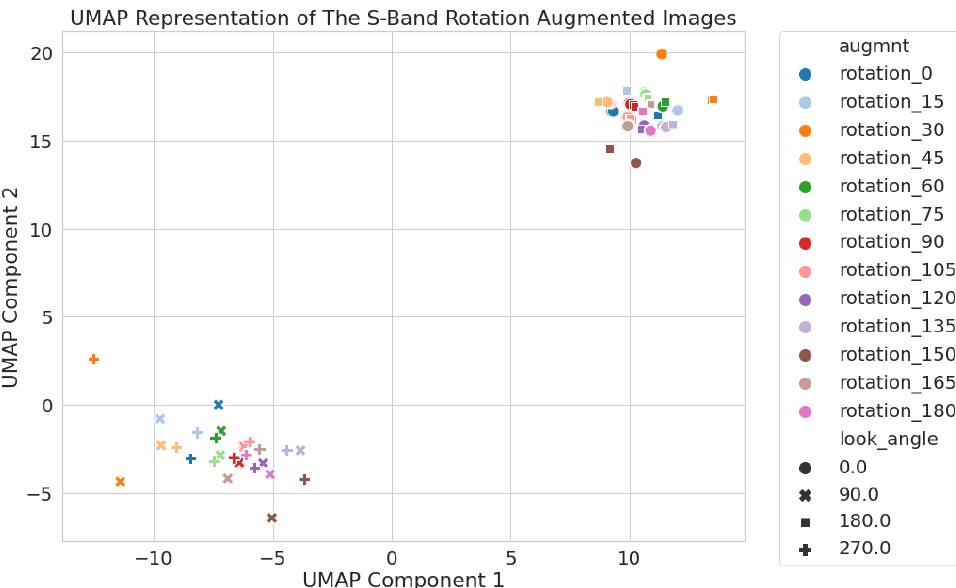
Figure 6. S-band only 2D UMAP latent space using circular crop images. All rotation augmentations are used, and the results show two clusters of images based on the look angle, 0 ◦ and 180 ◦ in the upper right and 90 ◦ and 270 ◦ are in the lower left.